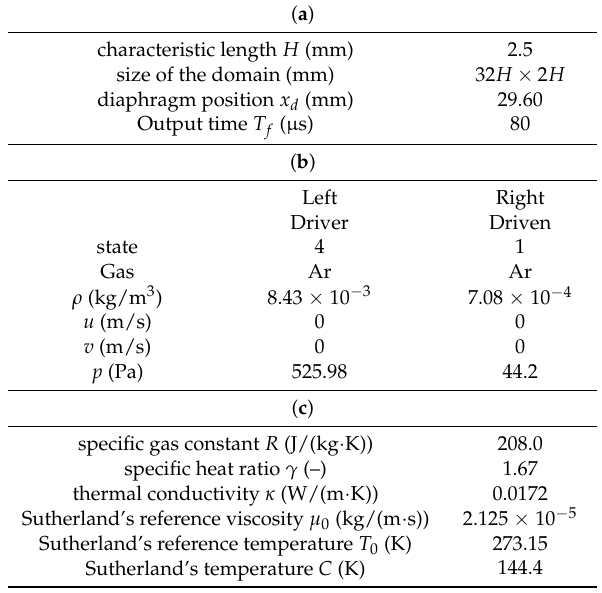
Table 2. Zeitoun’s test case: geometric information and output time for the simulation ( a ); flow properties in the driver and driven chambers ( b ); and Argon properties in standard condition ( c